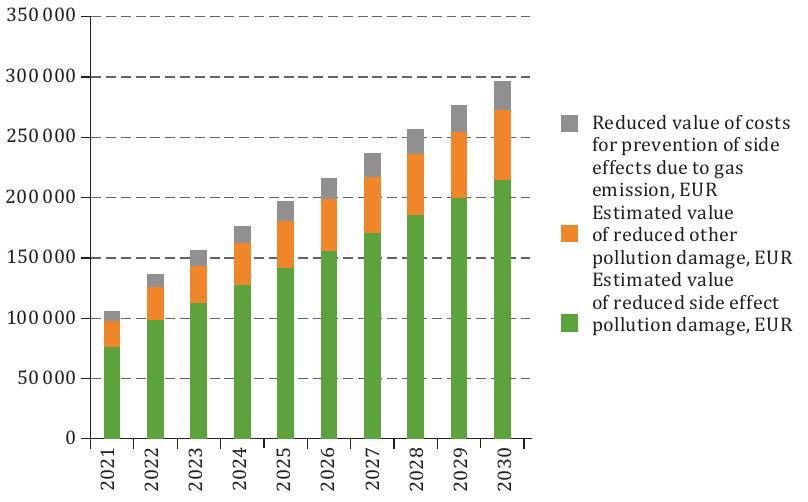
Figure 4. Planned value of ecological savings in monetary terms (created by the authors)